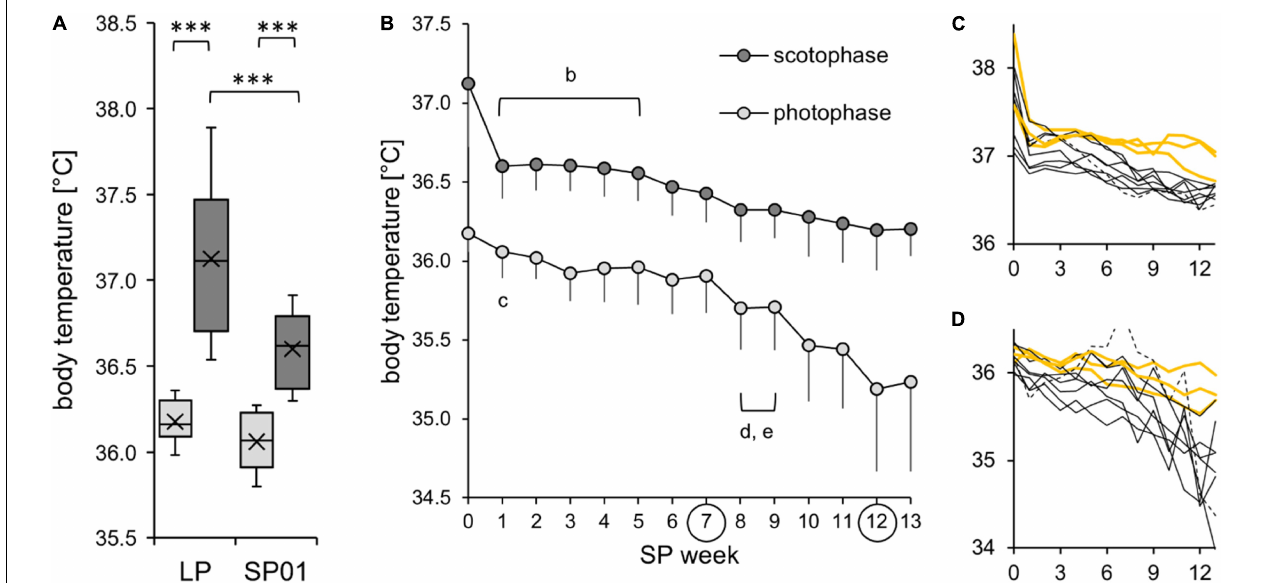
FIGURE 6 | Body temperature during the short photoperiod adaptation of approach 2. The exact values per hamster can be found in Supplementary Table 4 . (A) The cohort’s initial reduction of body temperature after the change of the light regime ( n = 10). Comparison of body temperature during photophase ( light gray ) and scotophase ( dark gray ) of the last week of the long photoperiod ( LP ) and the first week of the short photoperiod ( SP01 ). According to a two-way repeated measures ANOVA, body temperature was affected by both time frame [ F ( 1 , 9 ) = 62.256, p < 0.001, power = 1.0] and light regime [ F ( 1 , 9 ) = 83.125, p < 0.001, power = 1.0]. In addition, there was an interaction between the effects of time frame and light regime [ F ( 1 , 9 ) = 15.373, p = 0.004, power = 0.9). Post hoc Holm–Sidak tests confirmed that body temperature was significantly higher during the scotophase in both LP and SP01 (*** p < 0.001). Furthermore, body temperature during the scotophase (*** p < 0.001) was significantly higher in LP than that in SP01. Hamster #06 was excluded because it performed a torpor bout on the second day of SP, which is atypical or usually not noticed. (B) The cohort’s further reduction of body temperature ( n = 10). With focus on the weeks from SP01 to SP07 without torpor expression, body temperature was reduced over the course of SP adaptation. Significant differences to the SP07 of scotophase ( b ) [one-way repeated measures ANOVA: F ( 6 , 54 ) = 7.599, p < 0.001] as well as of photophase ( c ) [one-way repeated measures ANOVA: F ( 6 , 54 ) = 4.851, p < 0.001], both confirmed with Holm–Sidak p < 0.001. With focus on the weeks from SP08 to SP12 including torpor bouts, body temperature was further decreased. Significant differences to the SP12 for scotophase ( d ) [one-way repeated measures ANOVA: F ( 5 , 45 ) = 4.978, p = 0.001, with Holm–Sidak p = 0.002] as well as for photophase ( e ) [Friedman repeated measures ANOVA: χ 2 ( 5 ) = 30.114, p < 0.001, with Tukey’s test p < 0.05]. Hyperactive hamster #06 was excluded since a stereotypic jumping during photophase was also reflected in the body temperature. (C,D) Individual reduction of body temperature during scotophase (C) and photophase (D) for each of the 11 hamsters. Body temperature (in degree Celsius) is shown on the y -axis, the SP week on the x -axis, with hamster #06 as dotted line , the three “never torpor” hamsters as yellow lines , and all others as thin black lines